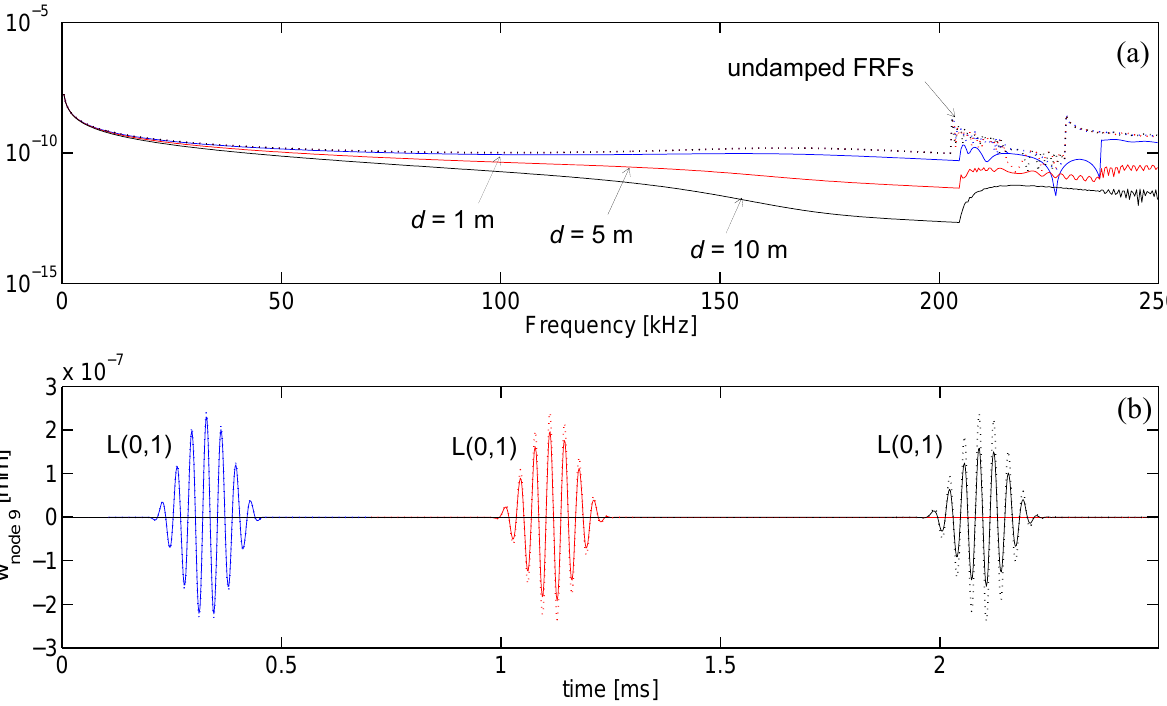
Figure 9 . Response for the z -dof of node 9 at three different distances source-receiver d = -z for the damped waveguide (continuous line) and for the undamped waveguide z R S (dotted line). (a) absolute value of the scaled frequency response function, (b) time- transient